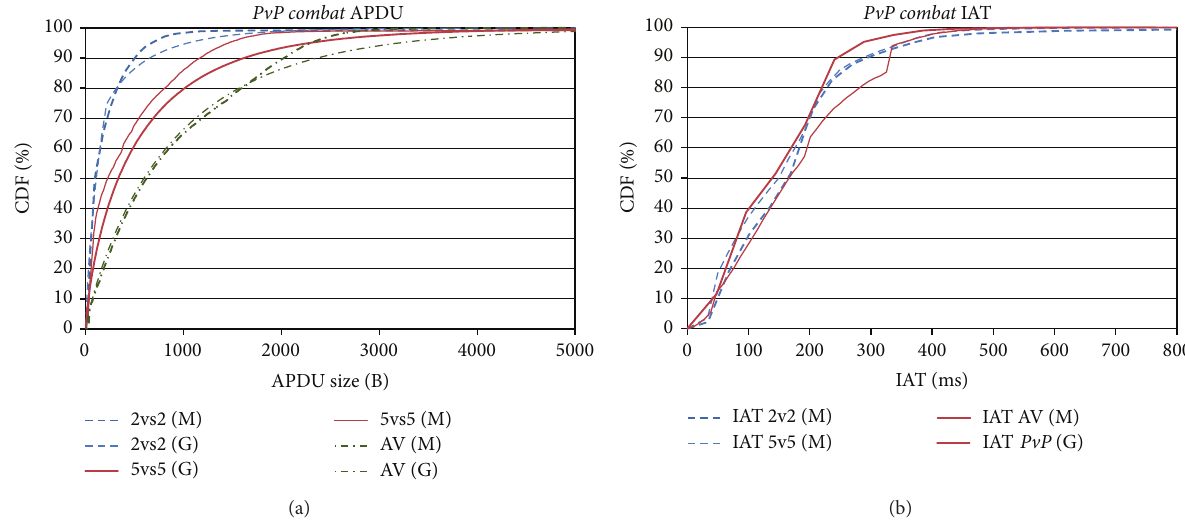
Figure 3: CDFs of (a) APDU (b) IAT, for different numbers of players for measured (M) and simulation generated (G) traces of PvP